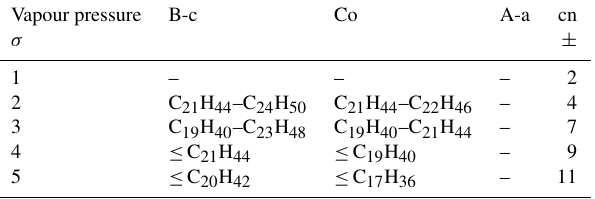
Table 3. Modal composition range and composition standard de- viations, σ , producing more realistic results that approximate REPARTEE-like behaviour. The vapour pressure parameterisations follow Myrdal and Yalkowski (1997; B-c in Fig. 3), Compernolle et al. (2011; Co in Fig. 3), and Nannoolal 2008; A-a in Fig. 3). Col- umn “cn” indicates the carbon number of compounds n in the modal composition with a contribution bigger than